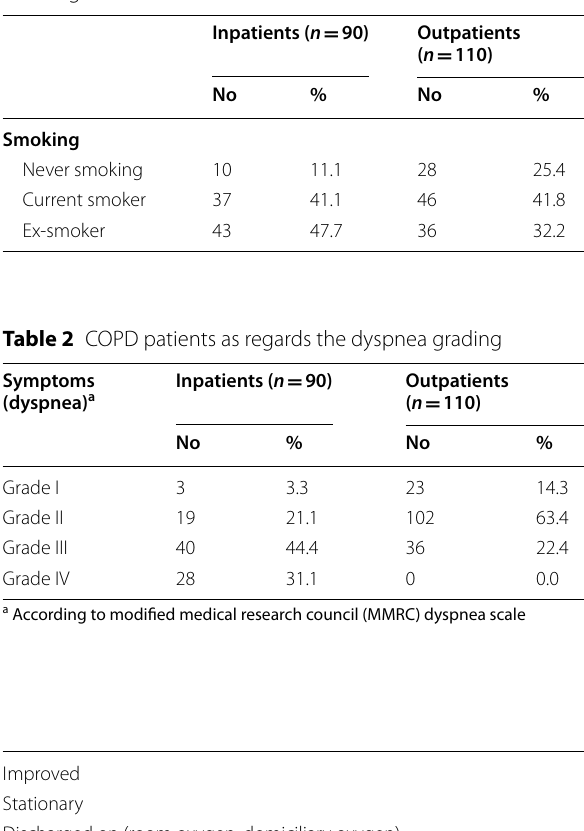
Table 1 Distribution of the two studied groups according to